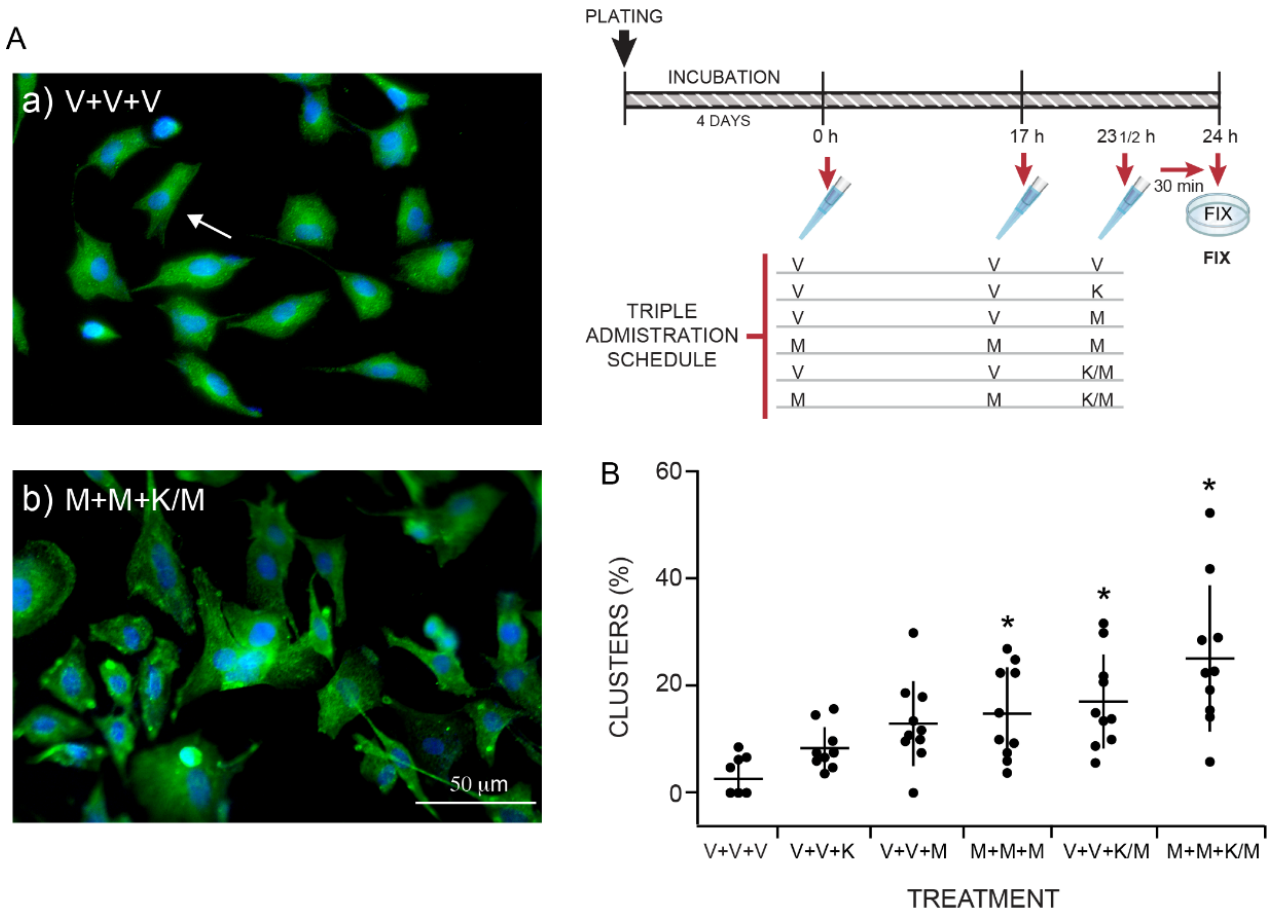
Figure 4. Incubation of ONPs with the triple administration schedule of melatonin/ketamine com- bination elicited cluster formation. Olfactory neuronal precursors were cultured with the vehicle added at time 0, 17 h and 23.5 h (V+V+V); or with VEH, VEH and KET; VEH, VEH, and MEL; MEL, MEL, and MEL; VEH, VEH, and KET/MEL or MEL, MEL, and KET/MEL combination (M+M+K/M). Panel A shows representative images of cells administered three times with the VEH ( a ) or with MEL+ MEL + KET/MEL combination ( b ). After fixation, cells were stained with DAPI (blue), and with an anti-nestin antibody (green). Single cells are noted using an arrow. Bar= 50 µm. Panel B : The graph shows the number of clusters counted in 10 fields in cultures treated as described and nor- malized by total cells in the field counted by DAPI staining. Each point in the graph represents the number of clusters counted in one field in the cultures incubated with the indicated treatments. Data are expressed as mean ± standard deviation obtained in ten fields. The experiment was repeated twice— and data were analyzed using a Kruskal–Wallis test followed by the Dunn´s post-test. * p = 0.007, when compared with the vehicle control group (V+V+V).